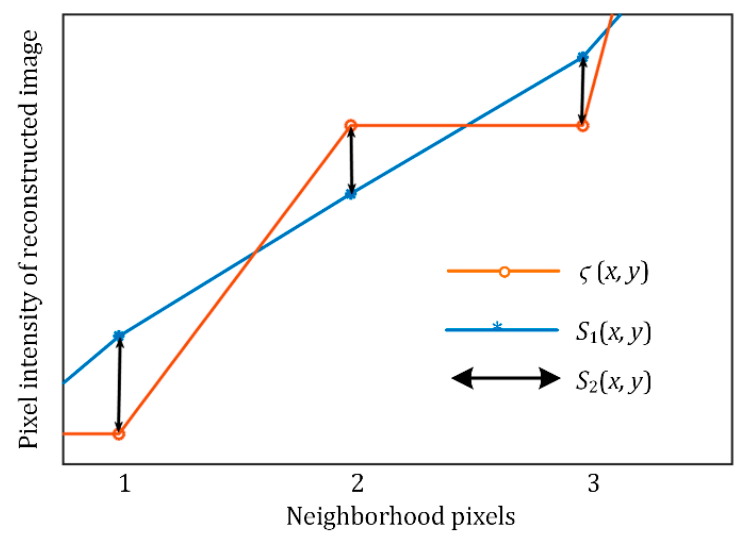
Figure 9. Relationship between adjacent pixels of ς ( x , y ) , s 1 ( x , y ), s 2 ( x , y ). Substituting (33) into (36) yields: 2 × [ s 1 ( x + 1, y ) + s 2 ( x + 1, y )] = [ s 1 ( x , y ) + s 2 ( x , y )] + [ s 1 ( x + 2, y ) + s 2 ( x + 2, y )] (37) The low-frequency coefficient after adaptive gamma correction is defined as W φ (cid:48) ( j 0 , m , n ); the corresponding reconstructed image of s 1 (cid:48) ( x , y ) is defined according to (34):